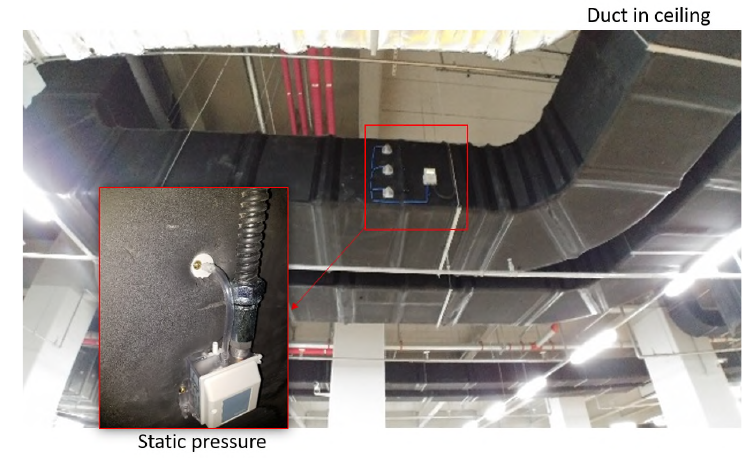
Figure 1. Duct and installed static pressure sensor.